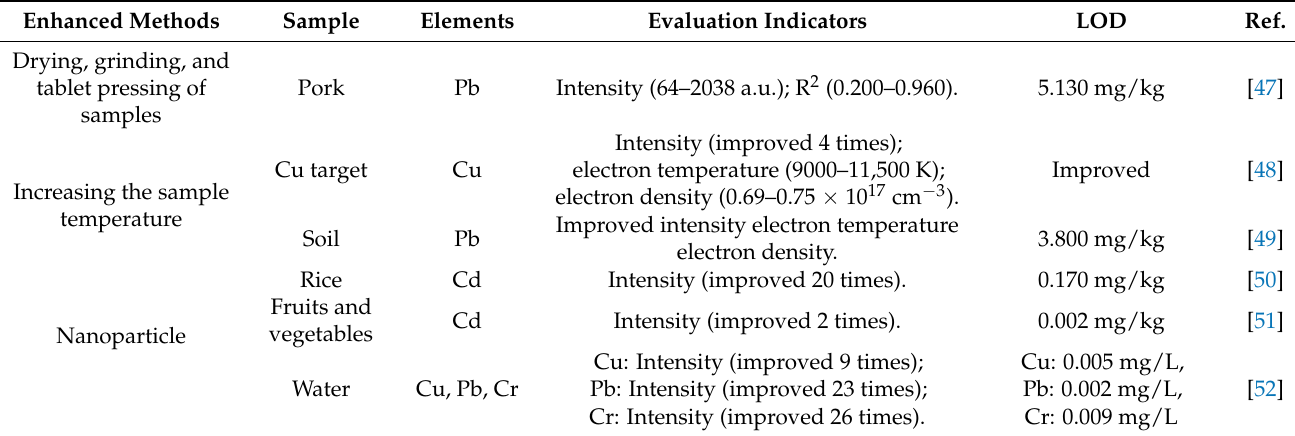
Table 1. Sample pretreatment enhanced LIBS for heavy metal